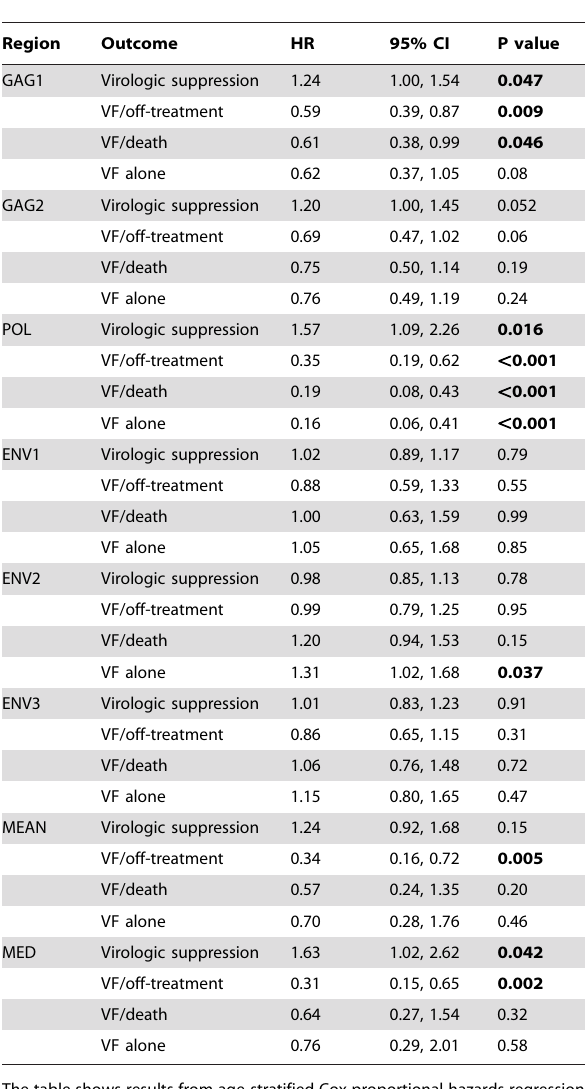
Table 4. Association of HIV diversity and time to virologic suppression and study